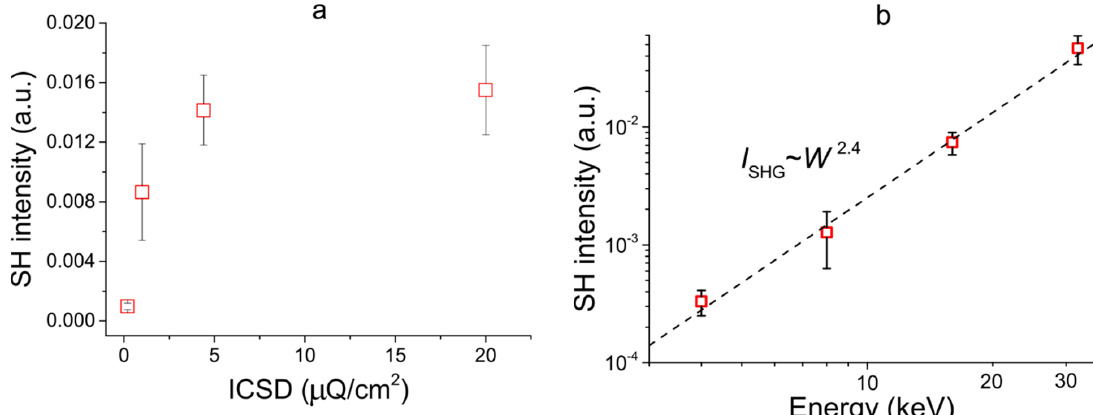
Figure 4. The SHG intensity from the irradiated BF16 glass in dependence on the ICSD for the electron beam energy 20 keV ( a ) and on the electron beam energy for ICSD of 40 µC/cm 2 (log-log scale). Squares—experiment, dashed line—approximation by a power function ( b ).